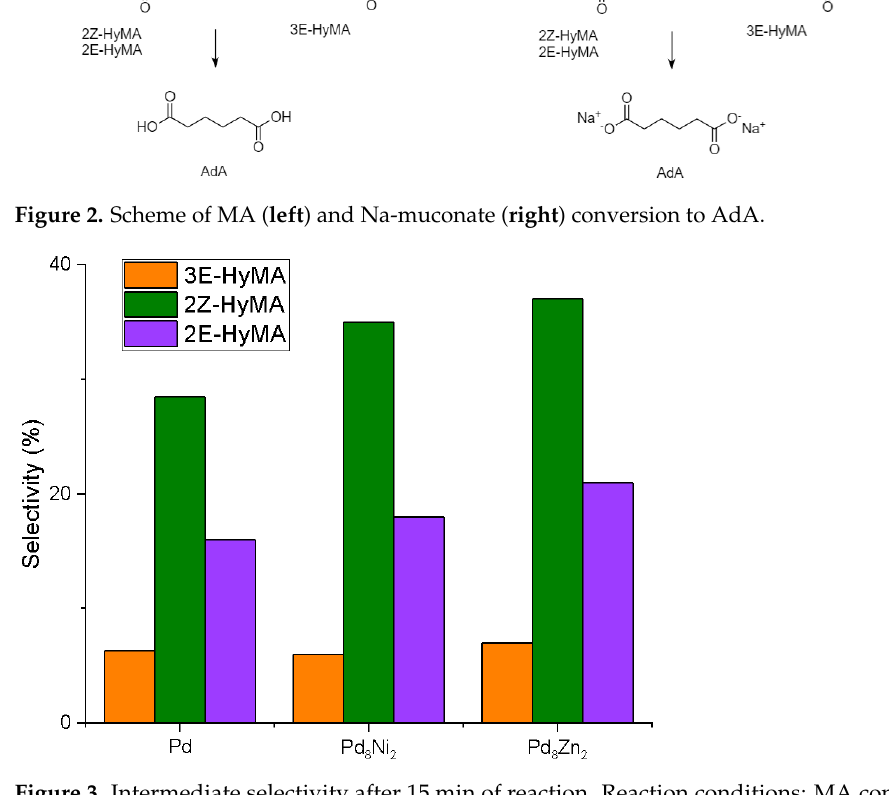
Figure 3. Intermediate selectivity after 15 min of reaction. Reaction conditions: MA concentration 0.1 M, temperature 70 °C, 2 bar pressure of H 2 , metal/substrate ratio 1/500.